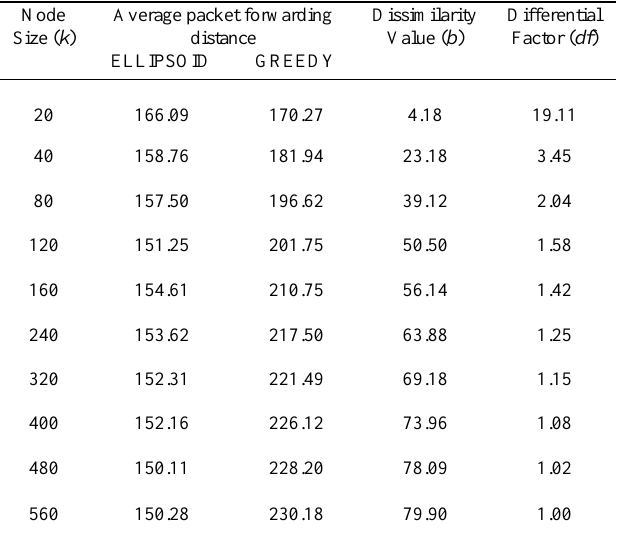
Table 3. Topology character of the MANET environment